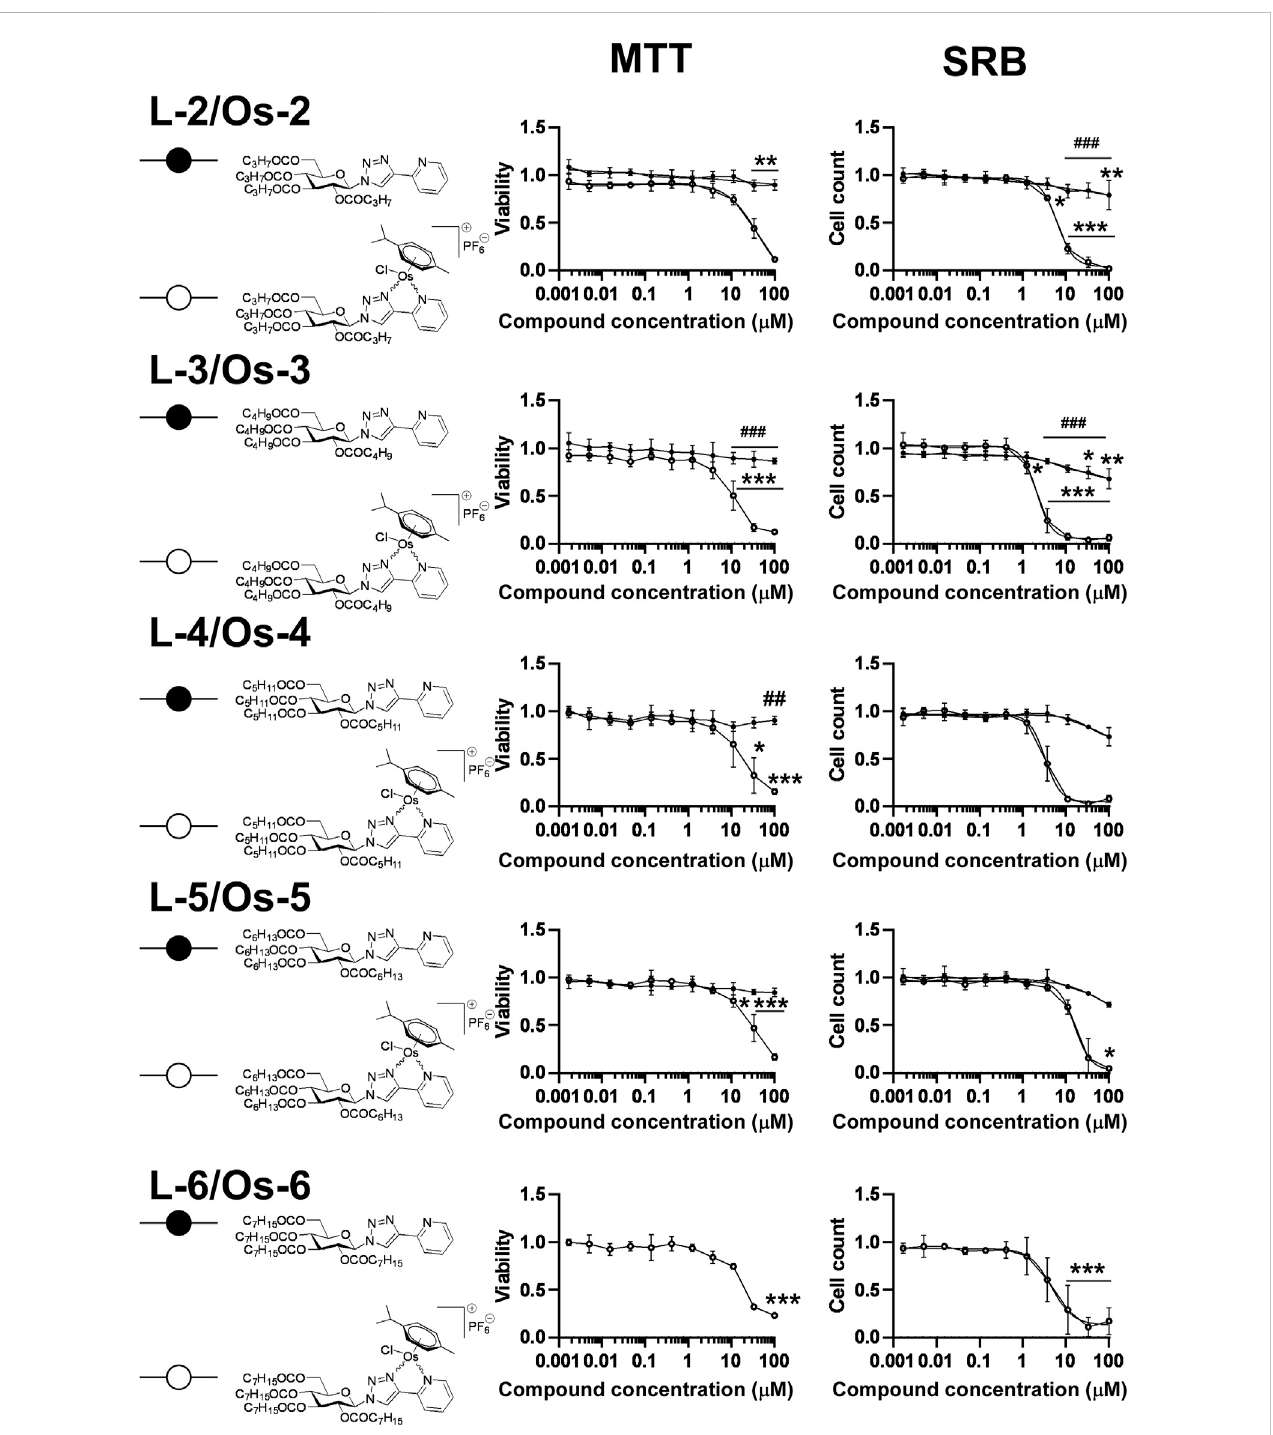
FIGURE 3 Assessmentoffreeligands L-2 — L-6 andosmiumcomplexes Os-2 — Os-6 forcytotoxicandcytostatic activity.3×10 3 A2780cells,wereplatedto96well plates.Cellsweretreatedwiththecompoundsintheconcentrationsindicatedforeither4 hforan MTTassayorfor48 hforanSRBassay.Data isrepresented asaverage±SD,fromthreebiologicalreplicates;individualassayswereperformedinduplicates.Valueswerenormalizedforvehicletreatedcells,absorbance for vehicle treated cells equals to 1. The MTT dataset for Os-3+L-3 and the SRB datasets for Os-2+L-2, Os-3+L-3 showed normal distribution, the MTT datasetsfor Os-2+L-2,Os-4+L-4,Os-5+L-5,Os-6 andtheSRBdatasetfor Os-4+L-4,Os-5+L-5,Os-6 wasnormalizedusingtheBox-Coxmethod.Exceptfor the Os-6 complex, Two-way ANOVA test was performed and all values were compared with each other (Tukey ’ s post hoc test). For Os-6 One-way ANOVA was performed on Box-Cox normalized values followed by Dunnett ’ s post hoc comparing all values to the smallest treatment concentration. *, ** and *** indicate statistically signi fi cant differences between vehicle-treated (control) and the cells treated with a compound at p < 0.05, p < 0.01 and p < 0.001, respectively. ## and ### indicate statistically signi fi cant differences between the free ligand and the corresponding complex at p < 0.01 and p < 0.001, respectively. Non-linear regression was performed on the